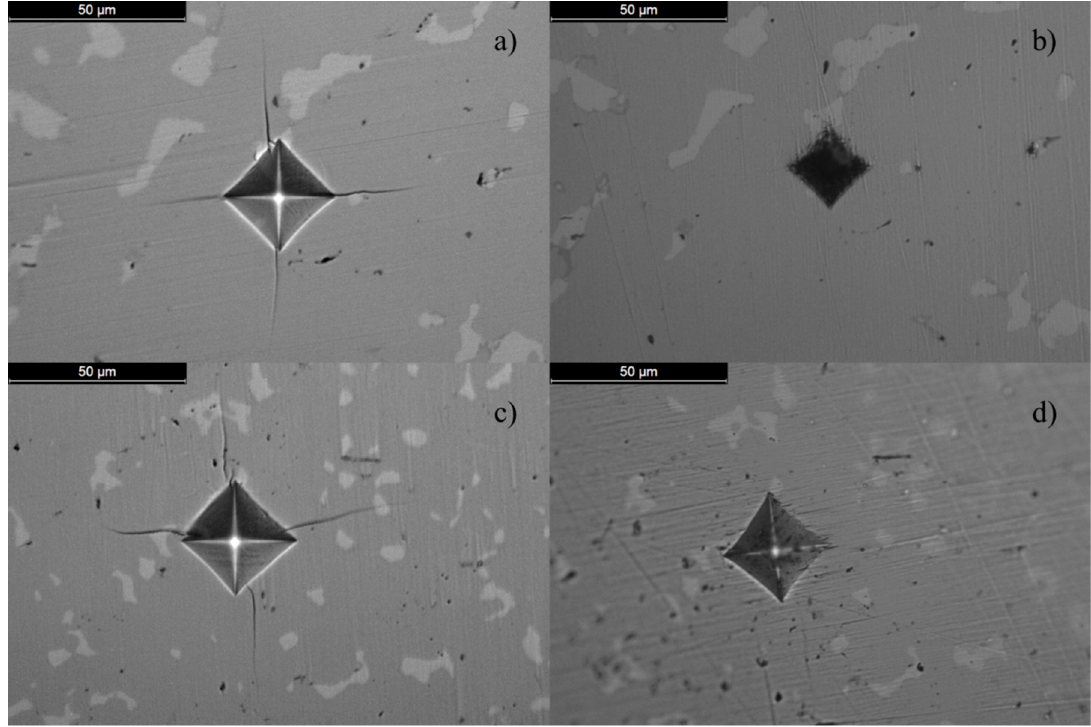
Figure 3. Examples of Vickers indentations on the Co 2 ZrSn (panel a and b ) and Co 2 HfSn (panel c and d ) alloys before ( a , c ) and after ( b , d ) light polishing.